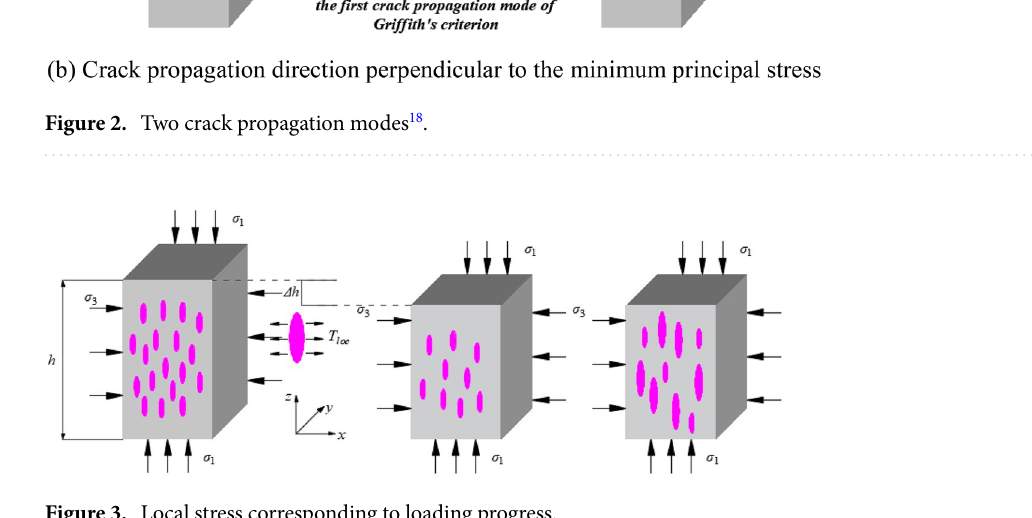
Figure 3. Local stress corresponding to loading